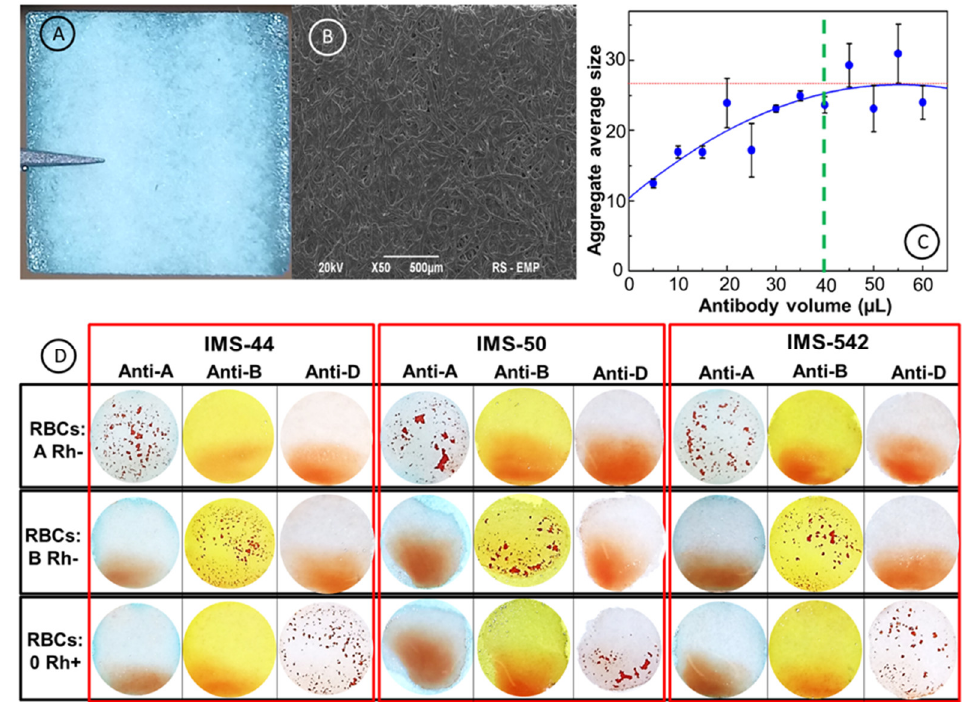
Figure 3. Images of paper immunostrips before and after tests with and without blood agglutina- tion. ( A ) Optical image of a paper immunostrip; ( B ) SEM image of a paper immunostrip; ( C ) dependence of the average RBC aggregate size on antibody volume (µL); ( D ) images of immunostrips after result of interactions of standard solution of RBCs of different types: A−, B− and 0+ with antibodies (Anti-A, Anti-B, and Anti-D) immobilized on immunostrips fabricated from IMS-44 (left panel), IMS-50 (middle panel), IMS-542 (right panel) cellulose papers. All experiments were performed on immunostrips and reagents warmed to room temperature.